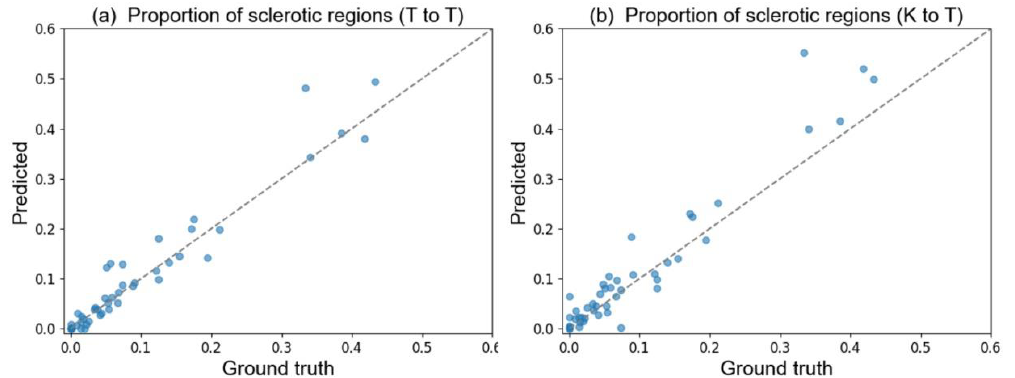
Figure A3. Scatter plots of the proportion of sclerotic regions between the ground truth and pre- dicted regions. ( a ) Sclerotic regions of T to T. ( b ) Sclerotic regions predicted by K to T. “T to T”